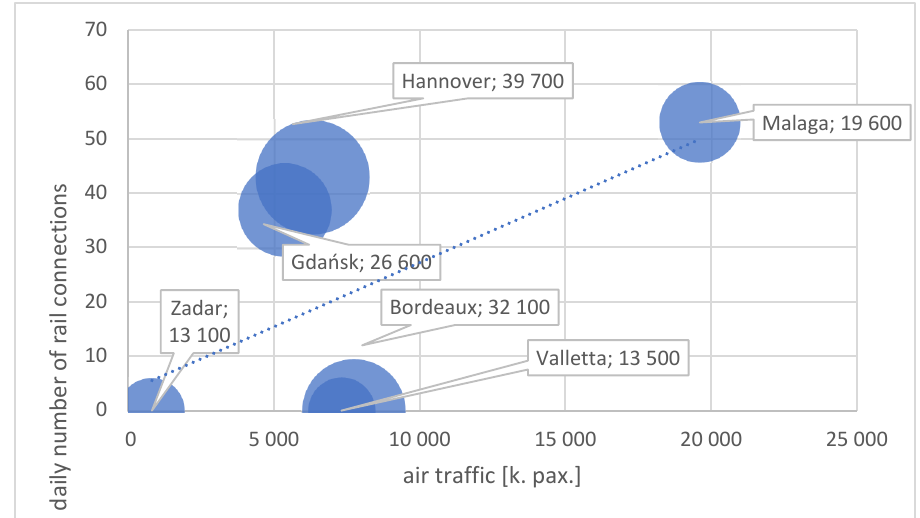
Figure 1. The relationship between the daily number of rail connections and air traffic/the region’s economic potential. Explanations: circle (airport) size—economic potential of the region (GDP per capita [EUR]); pax.—number of passengers. Source: own elaboration based on [45–50].